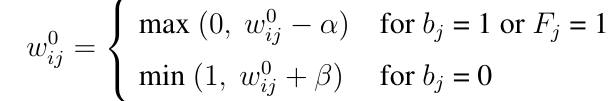
Figure 3. Dividing sensor nodes into three groups, R